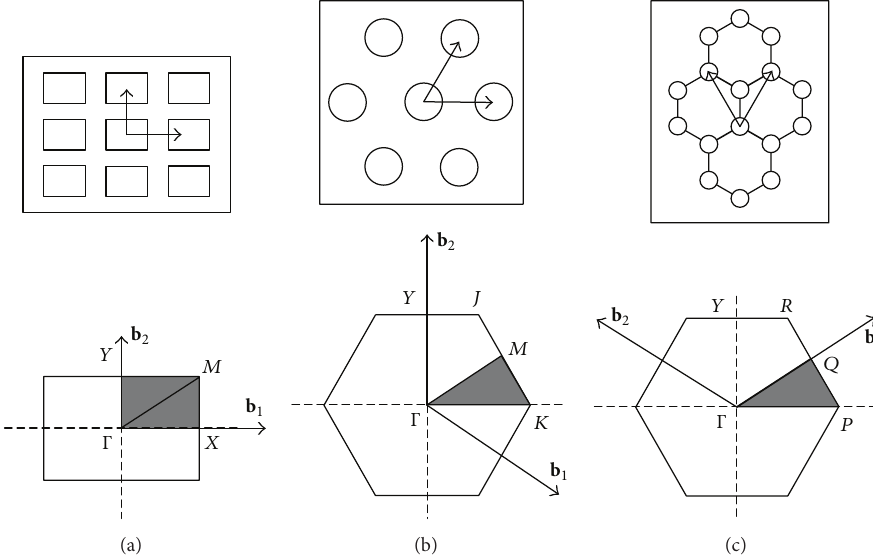
Figure 2: Wigner-Seitz unit cell and its first Brillouin zone: (a) orthogonal lattice, (b) triangular lattice, and (c) hexagonal lattice.